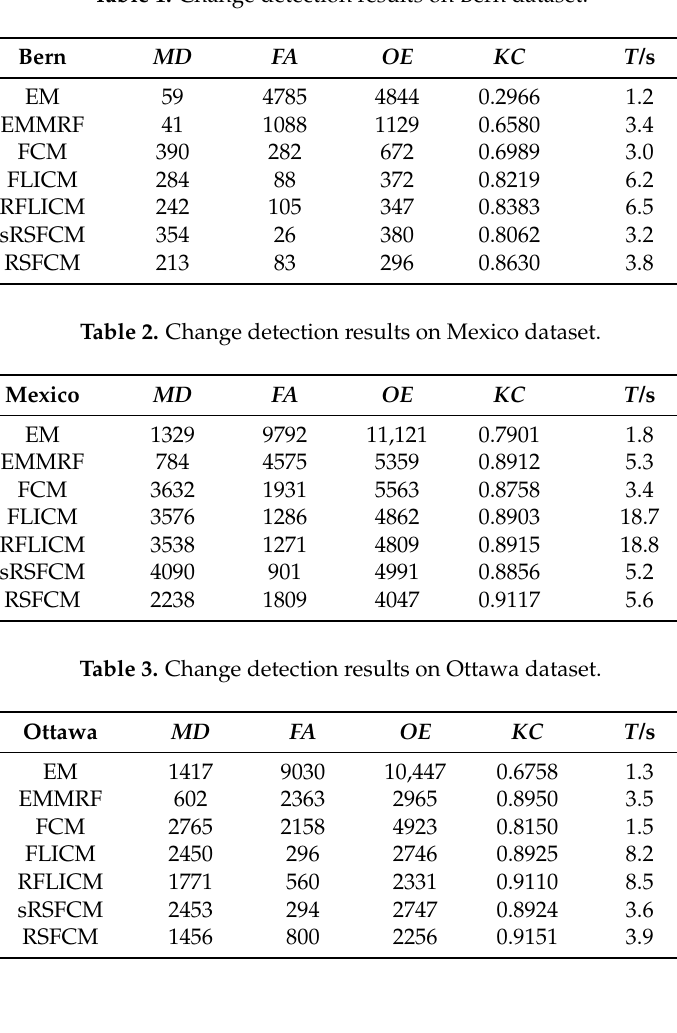
Figure 12. Final change detection maps of the Neimeng dataset produced by ( a ) EM; ( b ) EMMRF; ( c ) FCM; ( d ) FLICM; ( e ) RFLICM; ( f ) sRSFCM; ( g ) proposed RSFCM; and ( h ) reference image. Table 1. Change detection results on Bern dataset.